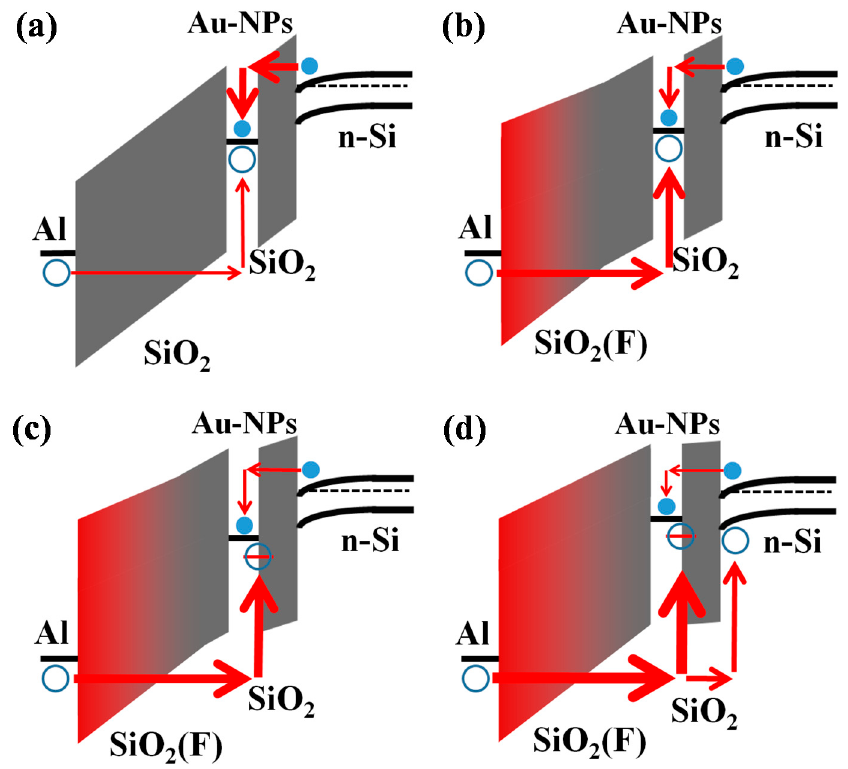
Figure 5. Schematic energy band diagrams of ( a ) w/o; ( b ) 20 W; ( c ) 30 W; and ( d ) 50 W samples at programming. Electrons and holes were injected from n -type Si substrate and Al gate, respectively, for the Au-NP NVMs without and with low-damage CF 4 plasma treatment on the BO layer.